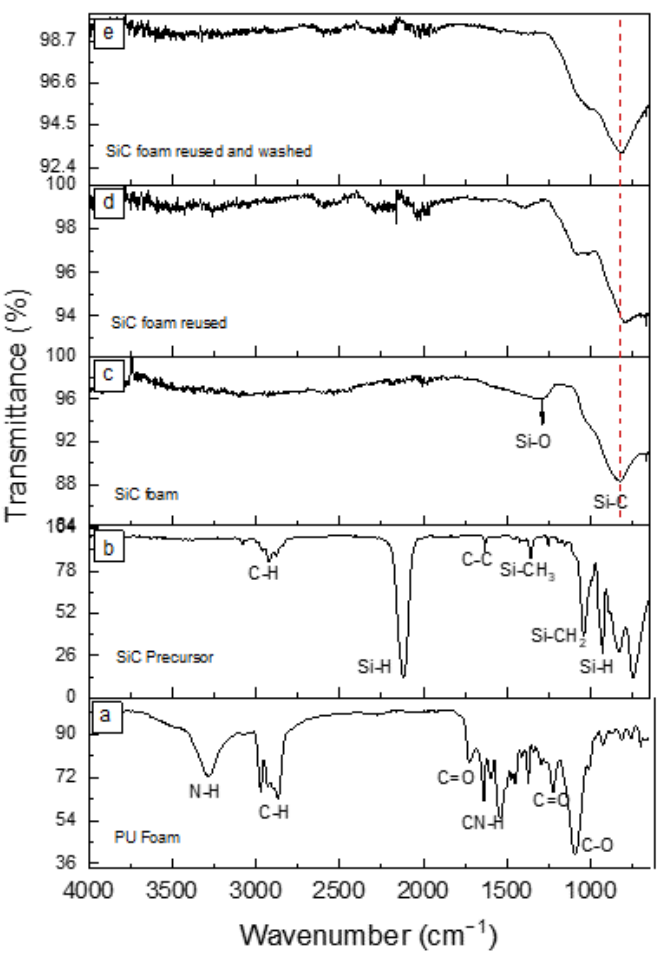
Figure 4. FTIR spectra for ( a ) PU foam template, ( b ) SiC precursor, ( c ) SiC foam, ( d ) SiC after photocatalytic experiment, and ( e ) SiC foam used and washed after photocatalytic experiment.